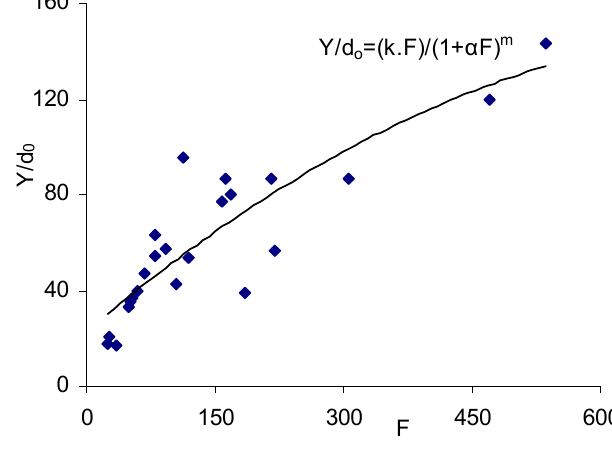
Figure 8. Normalized maximum jet centerline level as a function of the densimetric Froude number for an initial jet angle of 30°.